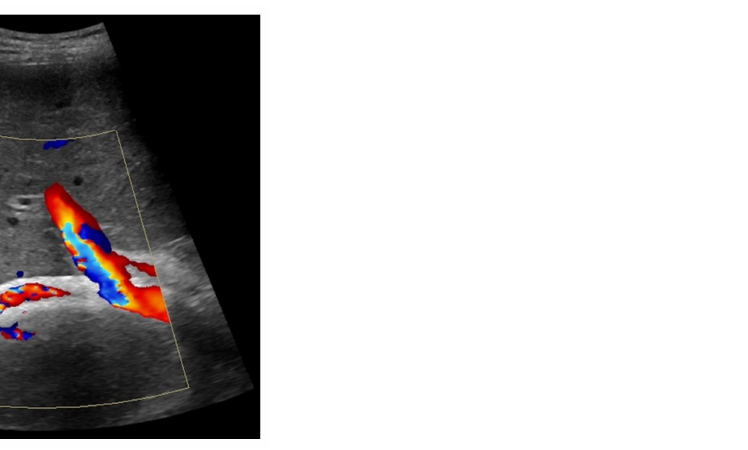
Figure 3. 44-year-old female patient with inhomogeneous flow signal on Color Doppler ultrasound as a sign of stent thrombosis.